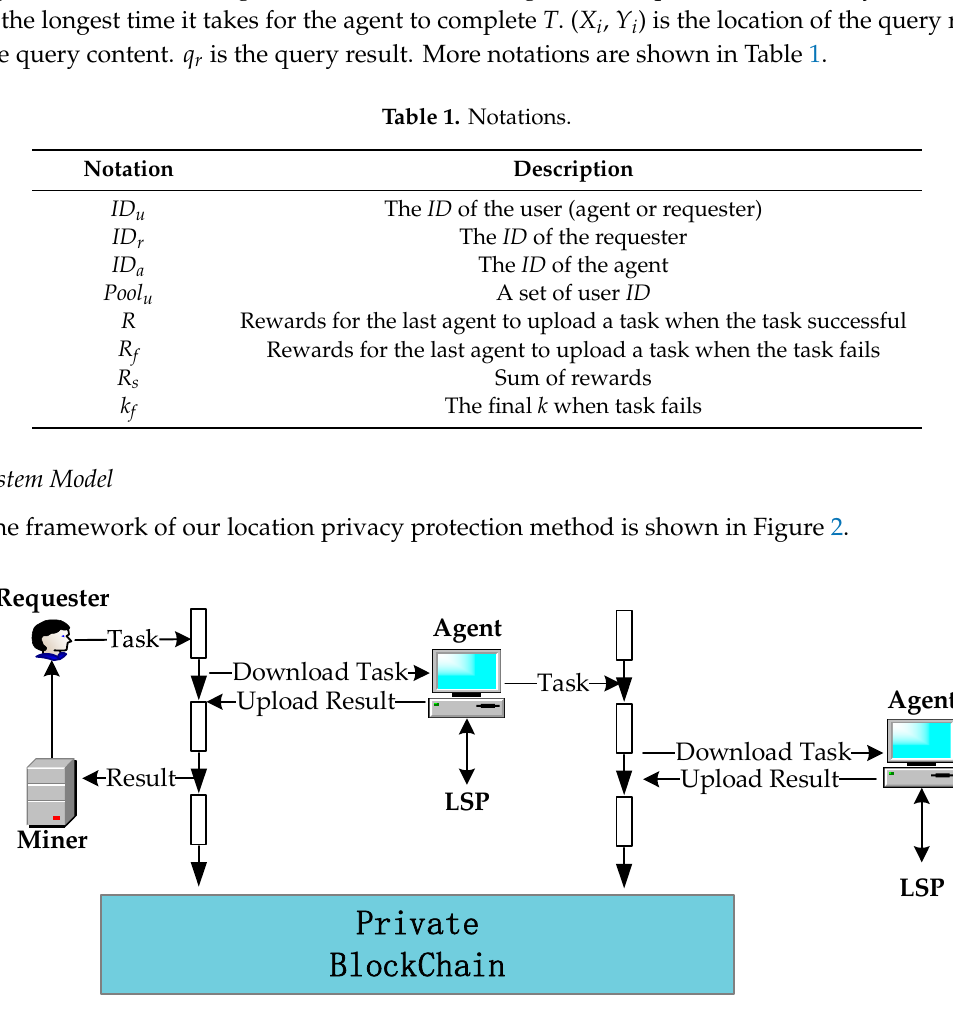
Figure 2. Framework of the proposed location privacy protection.